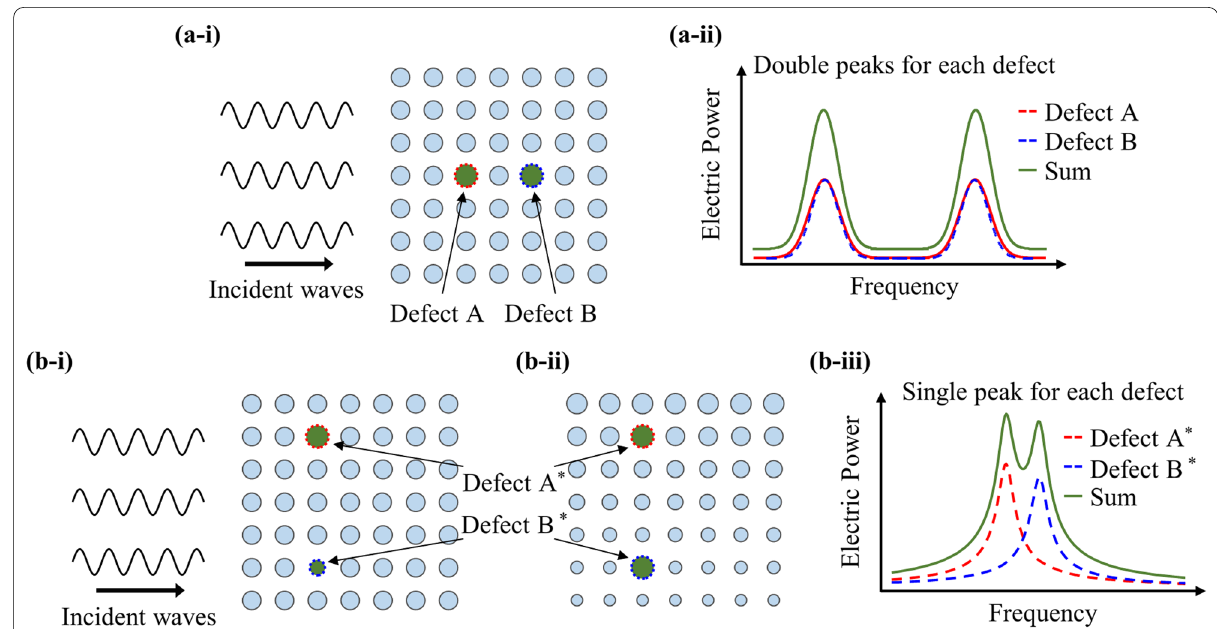
Fig. 1 Design concepts of a double‑defect‑introduced PnC and corresponding output electric power: a ‑ i a uniform PnC with coupled double defects introduced parallel to incident elastic waves, a ‑ ii broadband PEH by using defect‑band splitting, b ‑ i a uniform PnC with differently configured & decoupled double defects, b ‑ ii a graded PnC with identically configured & decoupled double defects, b ‑ iii broadband PEH by closely placing the defect band of each isolated defect